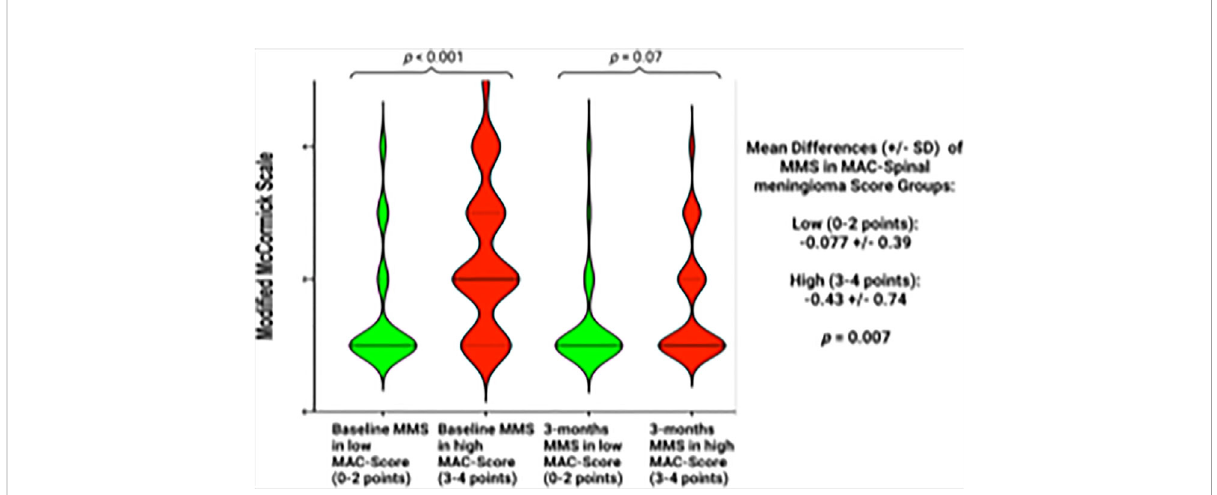
FIGURE 7 Violin plots displaying the Modi fi ed McCormick scale at the preoperative examination, and at 3-months after surgery in patients with a low MAC-Spinal Meningioma score (0-2 points, green violin plot) or a high MAC-Spinal Meningioma score (3-4 points, red violin plot). Violin plots show mean and distribution of Modi fi ed McCormick scale. The thick horizontal black lines are the median values. P -values of the Student´s t - test are